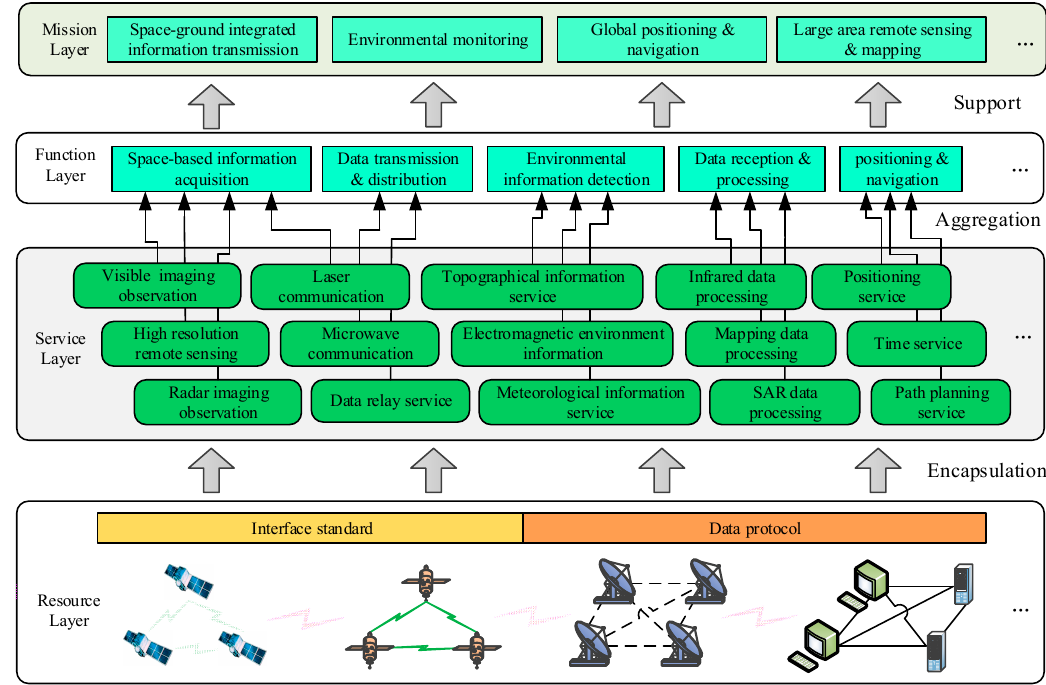
Figure 2. Functional-relationship diagram of the space-based information network.